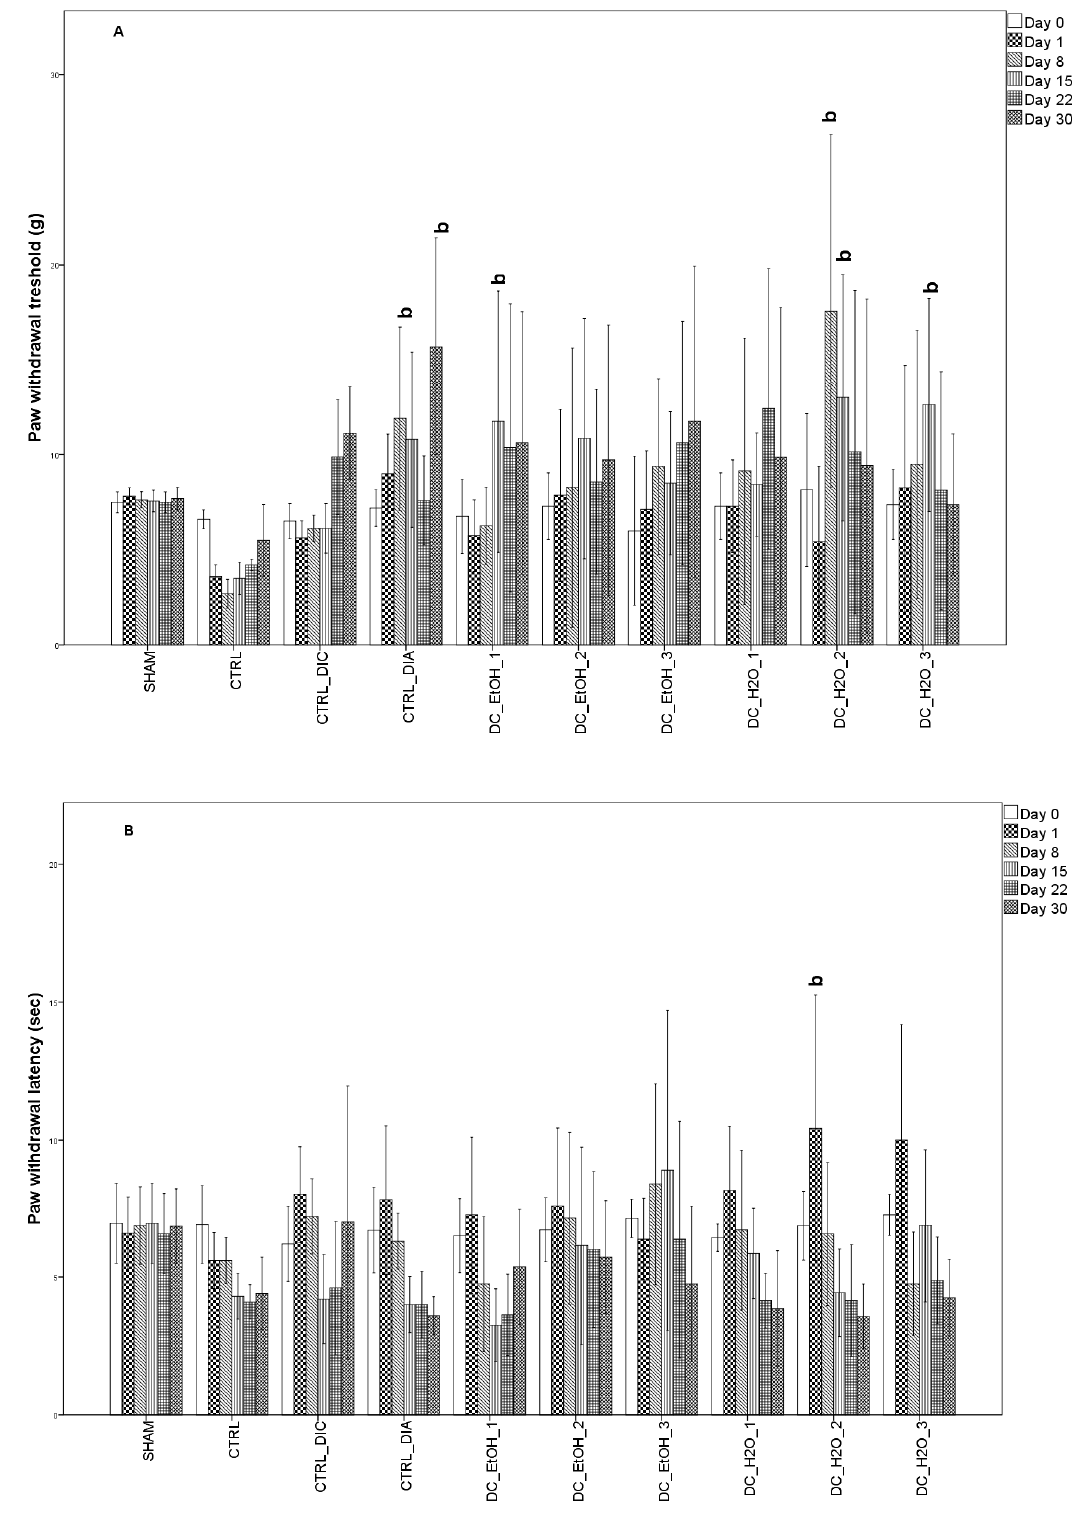
Figure 3. Effect of aqueous and ethanolic extract of Dichrostachys cinerea on mechano-allodynia (Analgesy-meter test) ( A ) and thermic induced pain (Hot plate test) ( B ). Data are presented as means ± SD (n = 10 for each group). For comparison between groups, one-way analysis of variance (ANOVA) with Tukey multiple comparison tests were used. Superscript ‘b’ indicates a significant difference ( p < 0.05) as compared to the CTRL group.